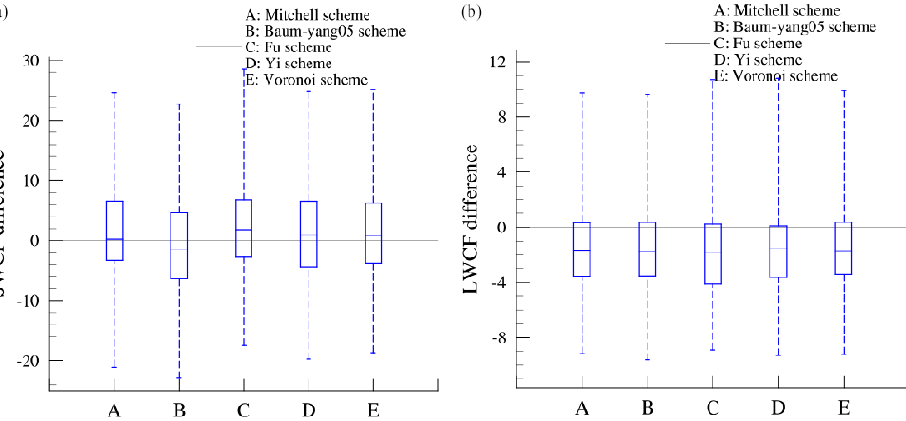
Figure 10. Box analysis of zonal distributions of 10-year annual mean SWCF (a) and LWCF (b) difference between the Mitchell, Voronoi, Fu, Baum-yang05 and Yi schemes and EBAF products,